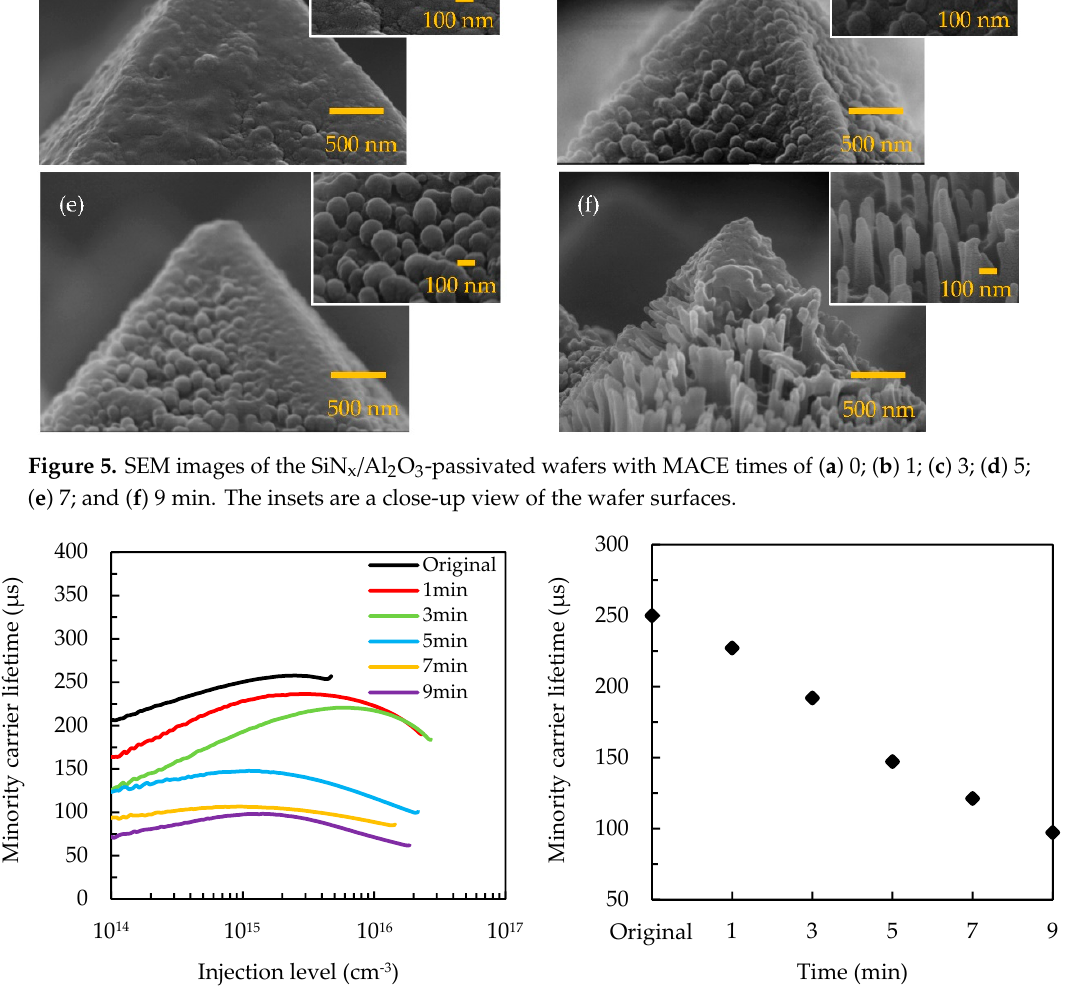
Figure 5. SEM images of the SiN x /Al 2 O 3 -passivated wafers with MACE times of ( a ) 0; ( b ) 1; ( c ) 3; ( d ) 5; ( e ) 7; and ( f ) 9 min. The insets are a close-up view of the wafer surfaces.